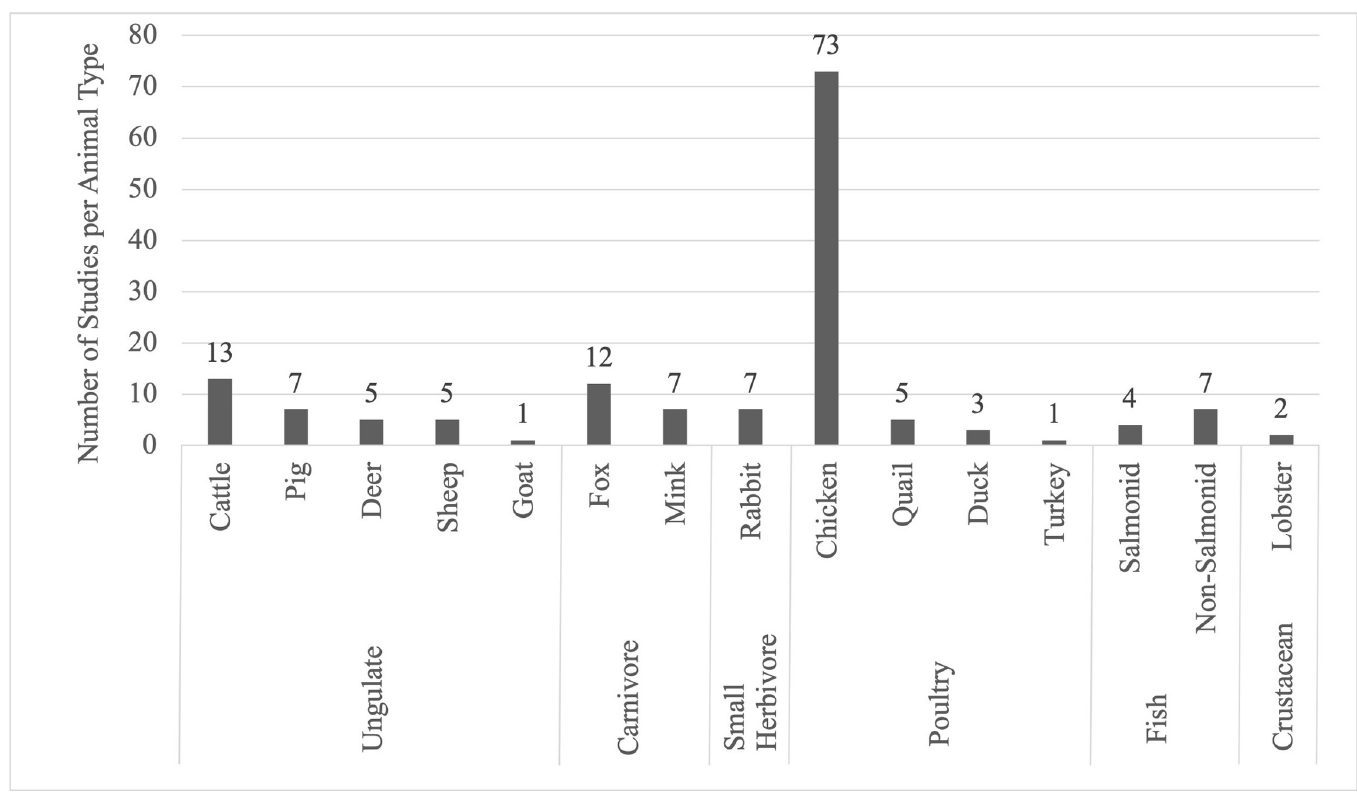
Fig 2. The number of studies per category and type of animal. From the 151 papers included in this scoping review, there were 6 categories (e.g., “ungulate”) and 15 types (e.g., “cattle") of animals represented. This figure shows the number of studies for each of the animal categories and types. One paper represented both turkeys and ducks, so this paper was categorized as both a ‘duck’ paper and a ‘turkey’ paper, resulting in 152 total papers in the